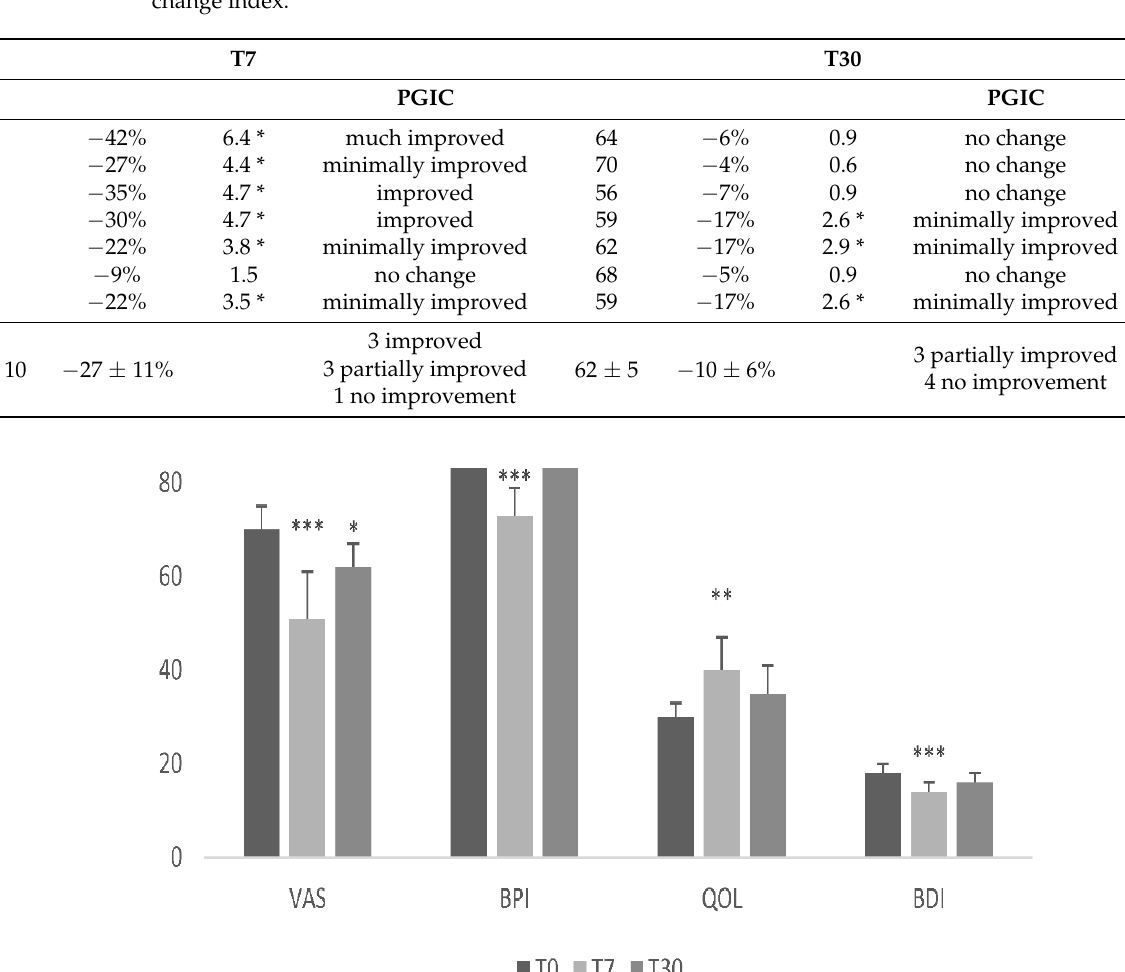
Table 2. Individual visual analog scale (VAS) and Patient Global Impression of Change (PGIC) values. Data are reported as mean with standard deviation, percentage change, or count. VAS includes raw